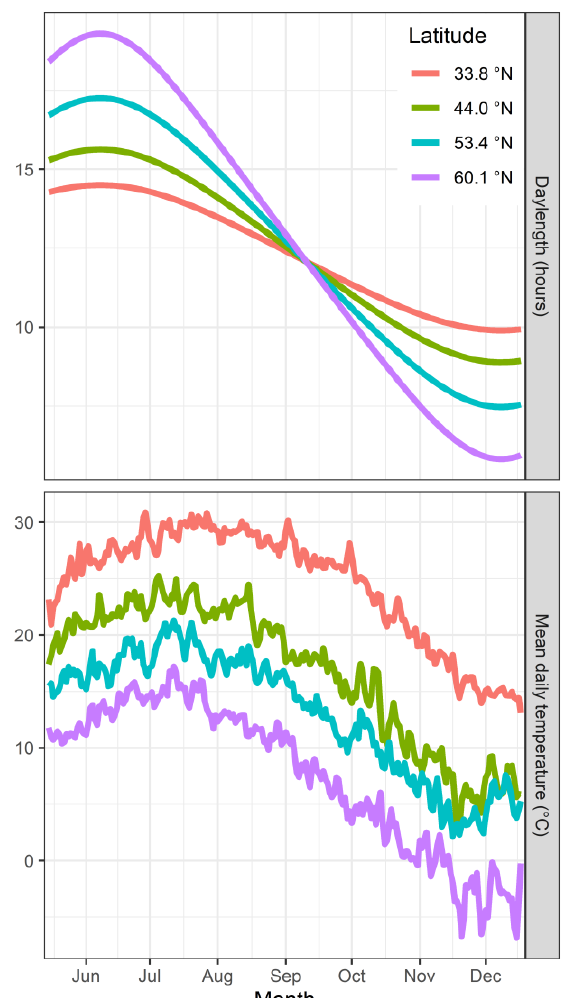
Figure 2. E ff ect of latitude (colored lines) on two environmental responses (daylength and daily mean temperature) in four northern-hemisphere locations. Data were acquired from the weather stations at Zarzis in Mellita, Tunisia (33.8 ◦ N, 10.7 ◦ E, 1 meters above sea level, m.a.s.l.); Montauban in Montauban, France (44.0 ◦ N, 1.3 ◦ E, 107 m.a.s.l.); Neuwiedenthal in Altes Land, Germany (53.4 ◦ N, 9.9 ◦ E, 3 m.a.s.l.); and Gustavfors in Bengtsfors, Sweden (60.1 ◦ N, 13.8 ◦ E, 188 m.a.s.l.). In the top panel, we show daylengths for each day of the year computed with equations by Spencer [32] and Almorox et al. [33] through a function in the chillR package [34]. The bottom panel shows mean daily temperatures based on daily minimum and maximum records of a six-year period (2012 to 2017). We downloaded these records from the Global Summary of the Day (GSOD) database from the National Climatic Data Centre (NCDC) of the United States National Oceanic and Atmospheric Administration (NOAA).